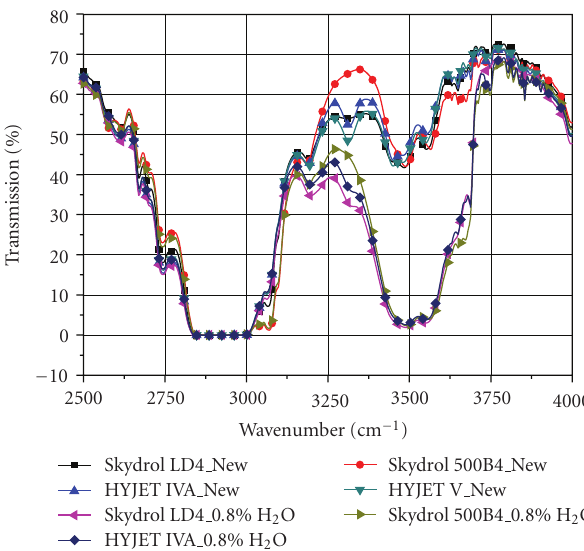
Figure 6: IR spectrum of di ff erent hydraulic fluids in their nominally pure state and the same fluids after addition of 0.8% water. Optical path length: 0.2 mm.